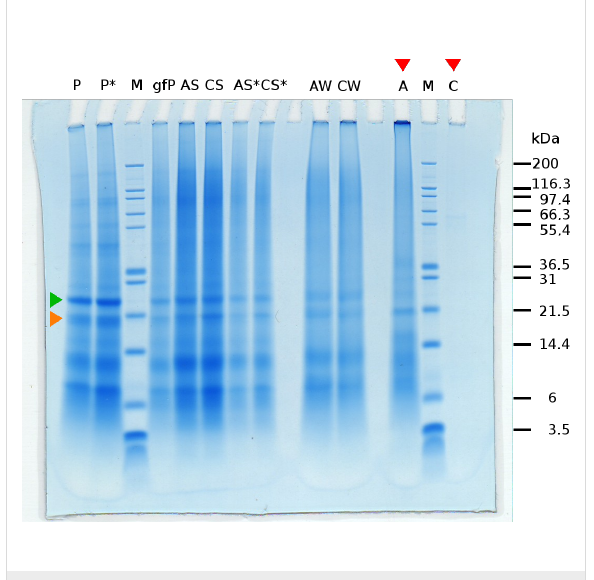
Figure 3: SDS-PAGE of proteins after different preparational steps as follows. M: marker proteins of known size. P , P*: protein solution of proteins that are insoluble in 6% acetic acid (chitin associated proteins), at two different concentrations. Orange marked band is less intensive than the green marked one. gfP: gel filtered protein solution. AS , CS , AS* , CS*: supernatant of incubated aragonite and calcite crystals, contains unbound proteins, at two different concentrations. AW , CW: combined washings of aragonite and calcite. A , C: acetic acid dissolved crystals after dialysis in sodium citrate buffer. Lane A now shows higher intensity of the orange marked band relative to green marked band, which may indicate specific binding of the orange marked protein to aragonite.